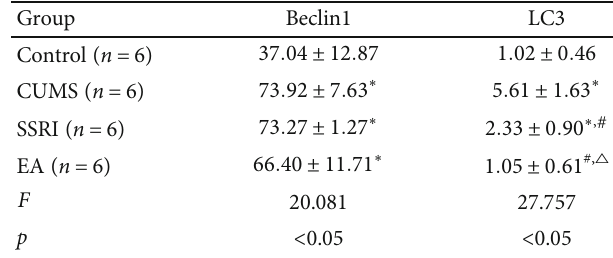
Table 3: Positive expression of Beclin1 and LC3 ( mean ± SD ,